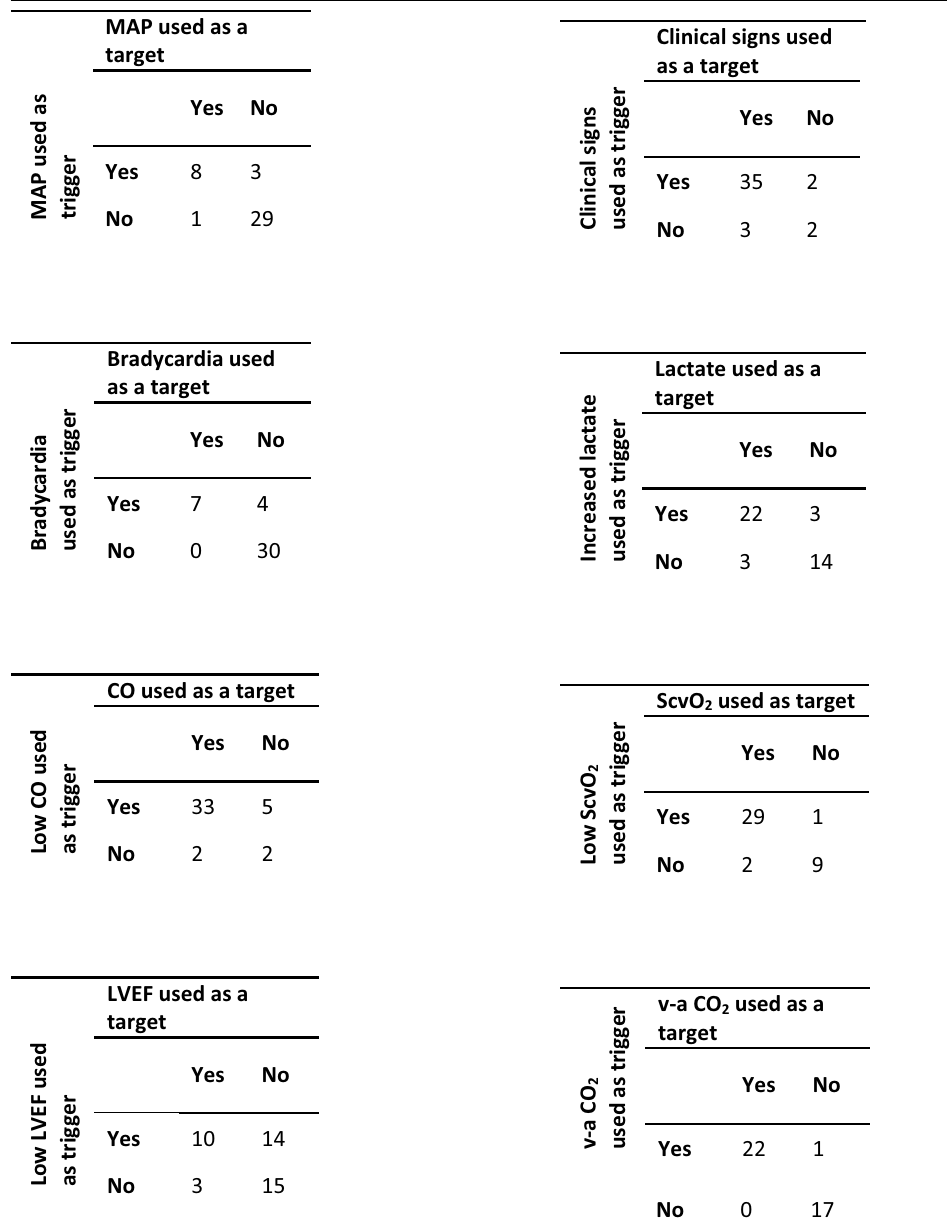
, and two for v-a CO 2 2